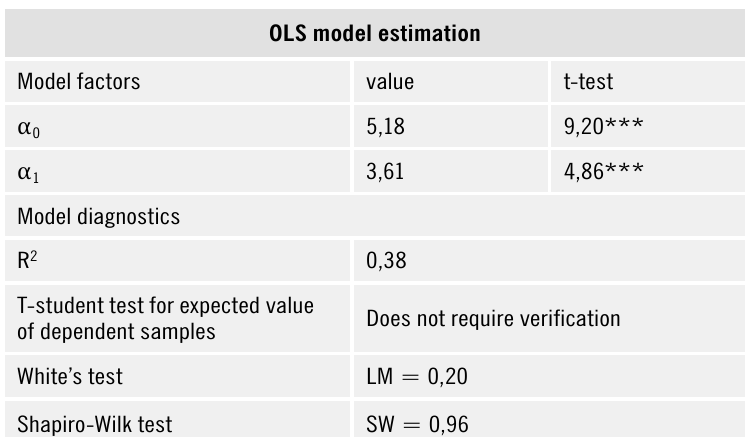
Table 2. Simple regression model for OF and GP _